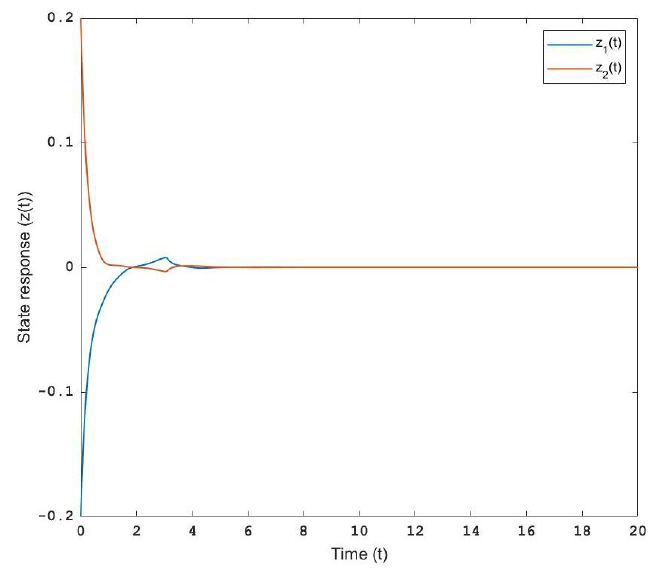
Figure 1. The state response of the system